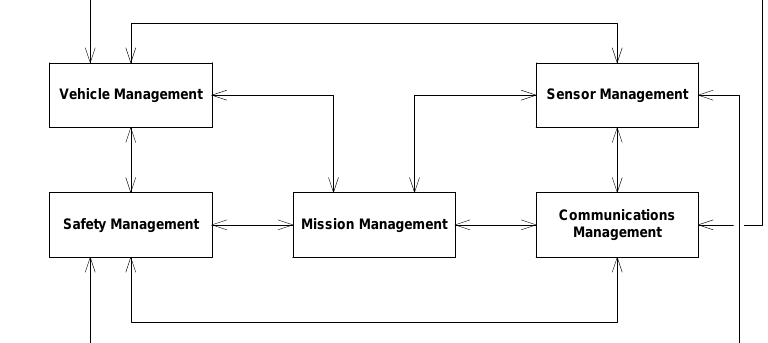
Figure 1. Top-Level System Architecture.